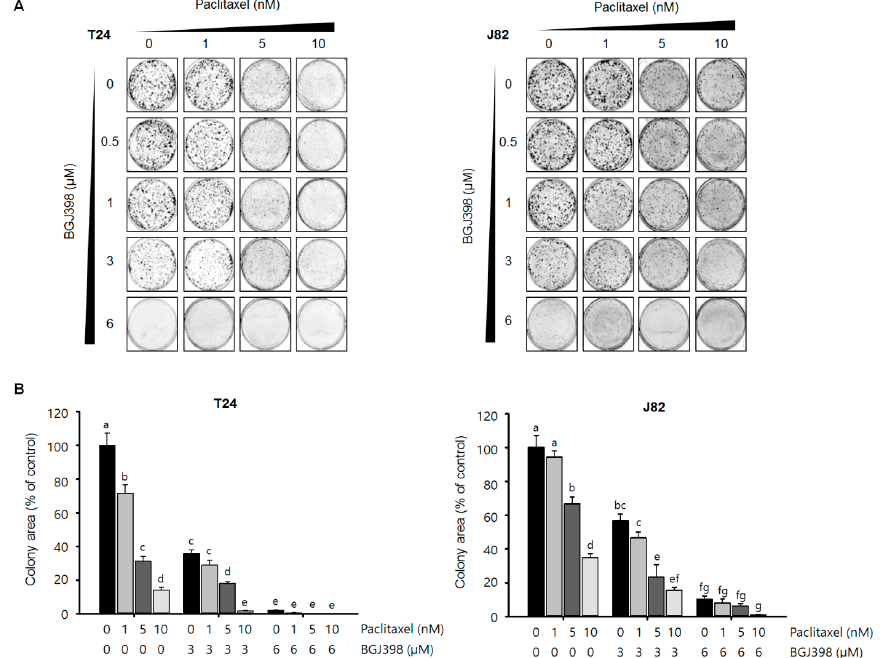
Figure 7. BGJ398 synergistically enhances the inhibitory effect of PTX on the colony forming ability of mesenchymal-type UC cell lines. ( A ) Colony size and number were reduced in a concentration-dependent manner upon combined treatment with BGJ398 and PTX. ( B ) Quantification of colonies. Different letters (a, b, c, d) indicate significant difference ( p < 0.05).